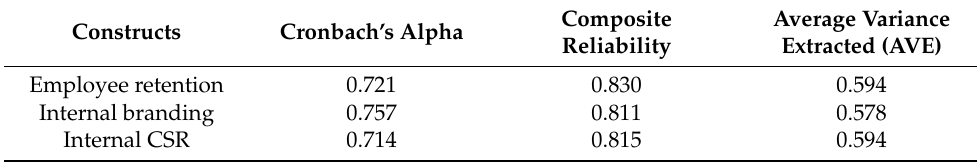
Table 2. Construct reliability and